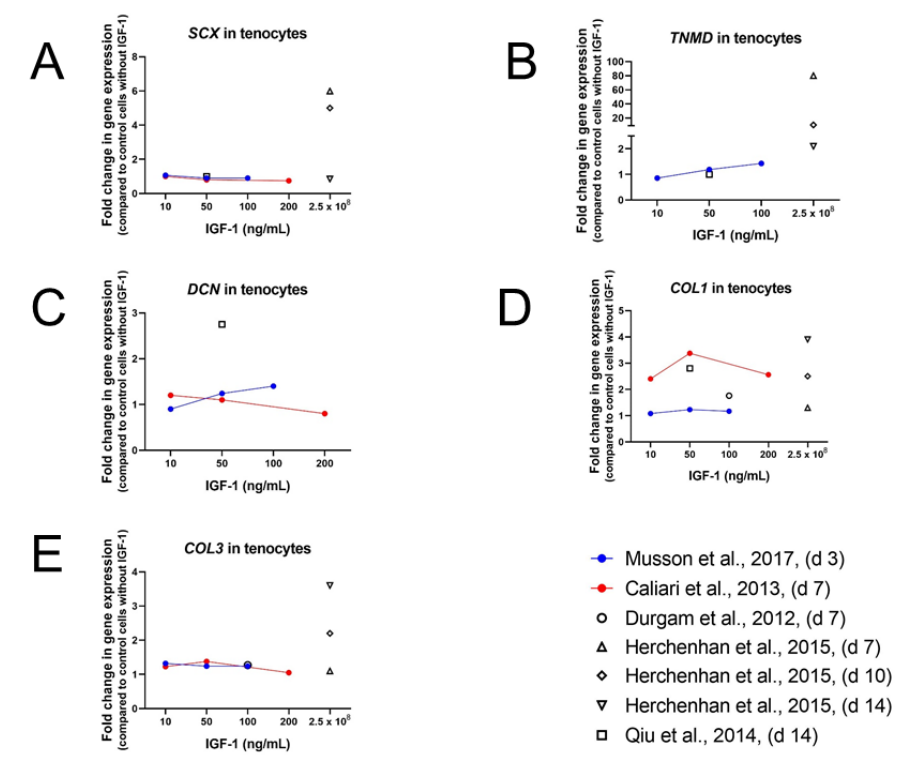
Figure 5. Impact of IGF-1 concentration on the gene expression of Scleraxis ( SCX ) ( A ), Tenomodulin ( TNMD ) ( B ), Decorin ( DCN ) ( C ), COL1 ( D ), and COL3 ( E ) after 3, 7, 10, or 14 days. Further information: Rat tenocytes in DMEM/F12 containing 0.5% FBS [80]; Equine tenocytes in DMEM without FCS [82]; equine tenocytes in high-glucose DMEM containing 10% FBS and AA (37.5 µ g/mL) [76]; human tenocytes in DMEM/F12 containing 0.5% FBS [91]; and human tenocytes in α -MEM without FBS [84]. Results from Musson et al. [80] confirm the positive influence of IGF-1 on TNMD gene expression as rat tenocytes treated with 10, 50, or 100 ng/mL IGF-1 and 0.5% supplemented FBS showed increased TNMD levels on day 3. However, other tenocyte-related gene expression ( SCX , COL1 , COL3 , DCN , and runt-related transcription factor-2 ( RUNX2 )) on day 3 remained unaffected after IGF-1 treatment at any dose. The expression of the osteoblastic marker alkaline phosphatase ( ALP ) and the chondrogenic marker aggrecan ( ACAN ) were significantly increased in a dose-dependent manner. On the other hand, expression levels of SOX9, a transcription factor essential for skeletal development among other things, decreased in a dose-dependent manner upon IGF-1 supplementation. Consistently with the results of human tenocytes cultured in serum-free medium also equine tenocytes cultured in serum-free medium and supplemented with IGF-1 (10, 50, and 200 ng/mL) showed significantly upregulated levels of COL1 [82]. The same effect could also be observed for COL3 —but smaller than for COL1 (Figure 5D,E). Measurements were carried out after 7 days and showed peak levels at the medium dose, which was also used in the experimental setting with the human tenocytes on day 14. In contrast to the significant upregulation of DCN in human tenocytes, mRNA level of DCN in equine tenocytes was only slightly upregulated at low dose and decreased dose-dependently at medium and high dose. The same result was obtained for Tenascin-C (TNC). Expression levels for SCX were not affected in human tenocytes with 50 ng/mL, which was also true for equine tenocytes with the lowest IGF-1 dose (10 ng/mL) on day 7. Higher